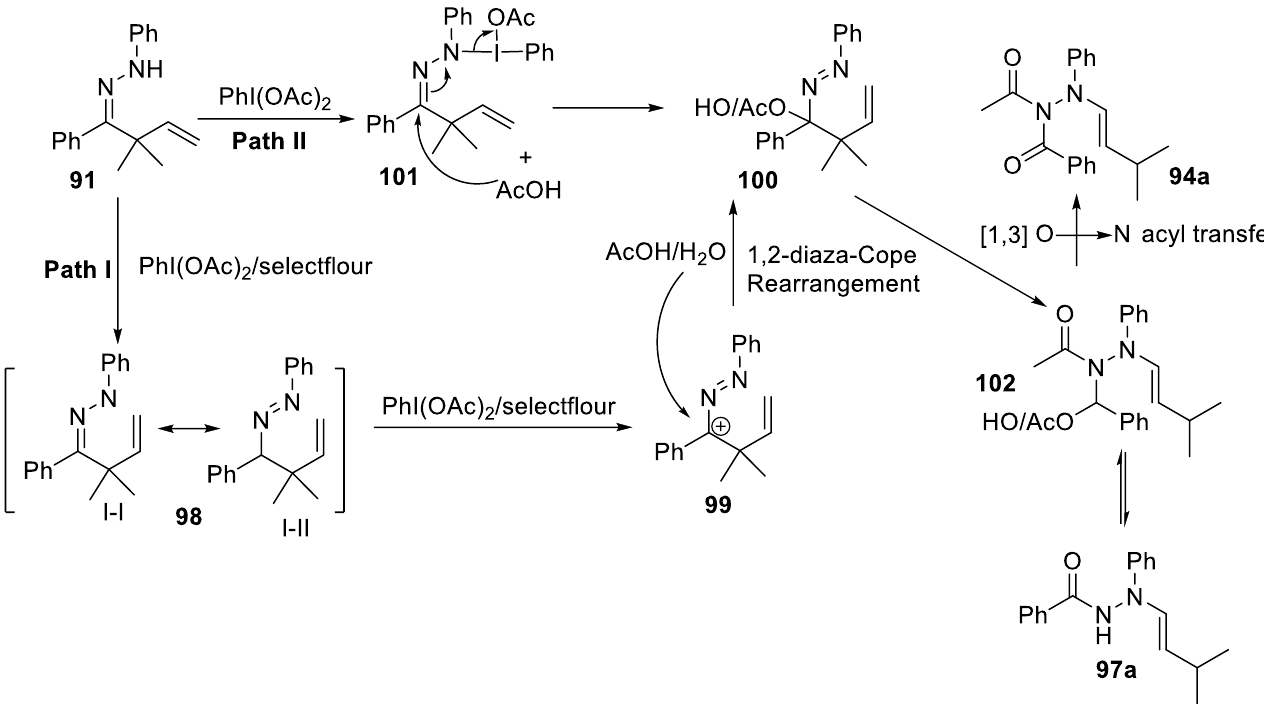
Figure 14. Proposed mechanism for PIDA-mediated 1,2-diaza-Cope rearrangement.